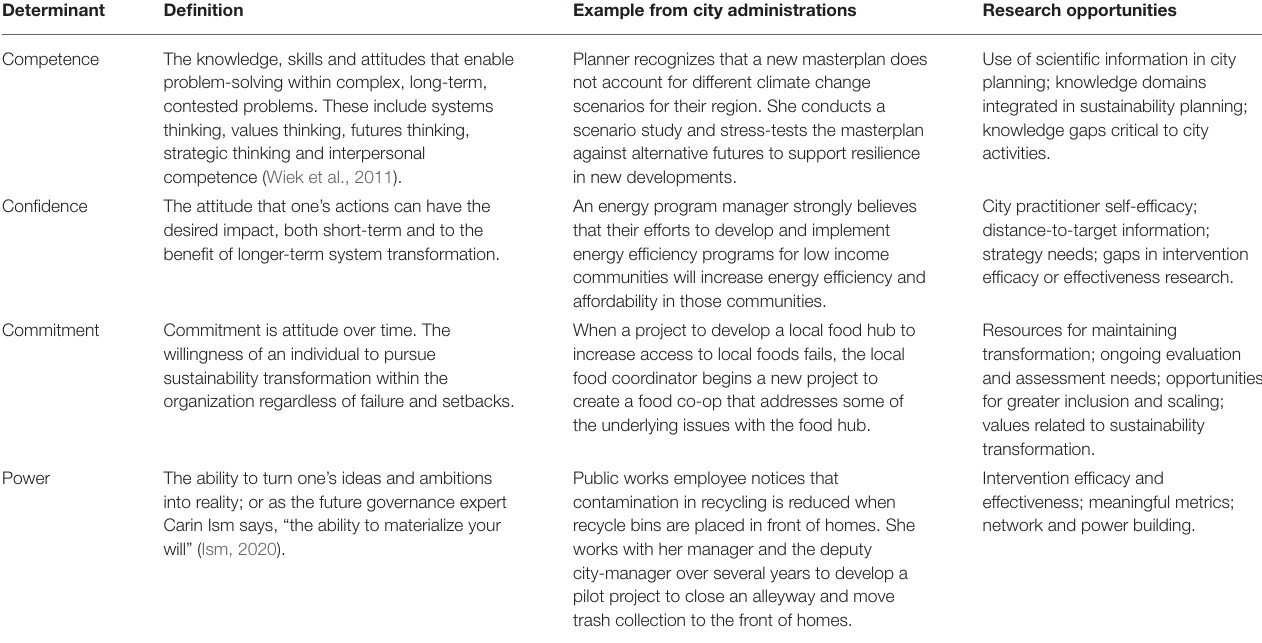
TABLE 1 | Determinants of actor-centric transformative-capacity (Keeler et al., 2019c) with examples.